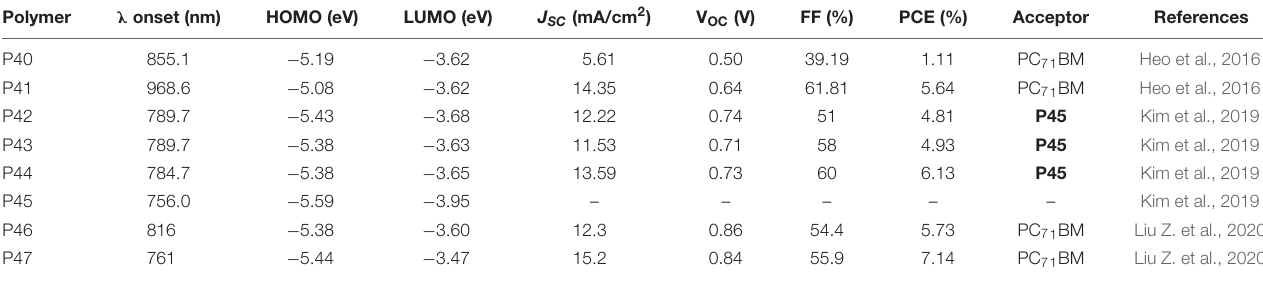
TABLE 4 | Summary of optical, electrochemical, and photovoltaic properties of polymers ( P40 – P47 ). Polymer λ onset